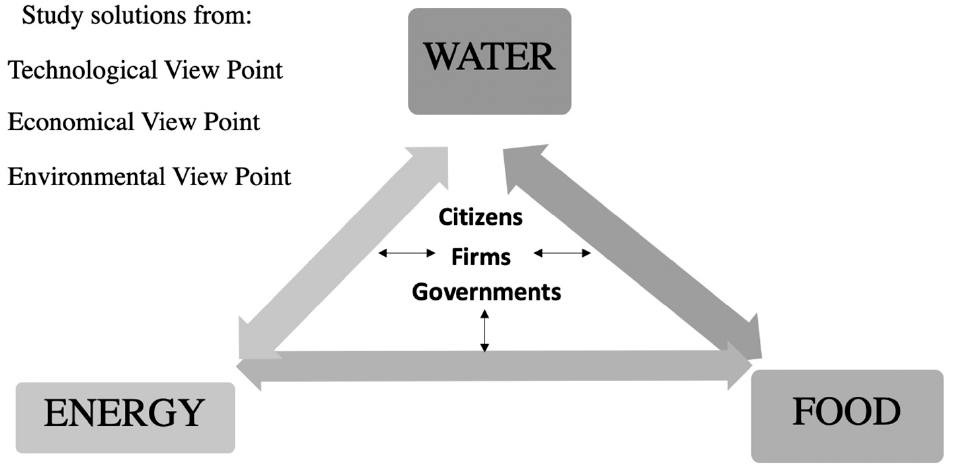
Figure 4. Environmental approach for WEF systems management.